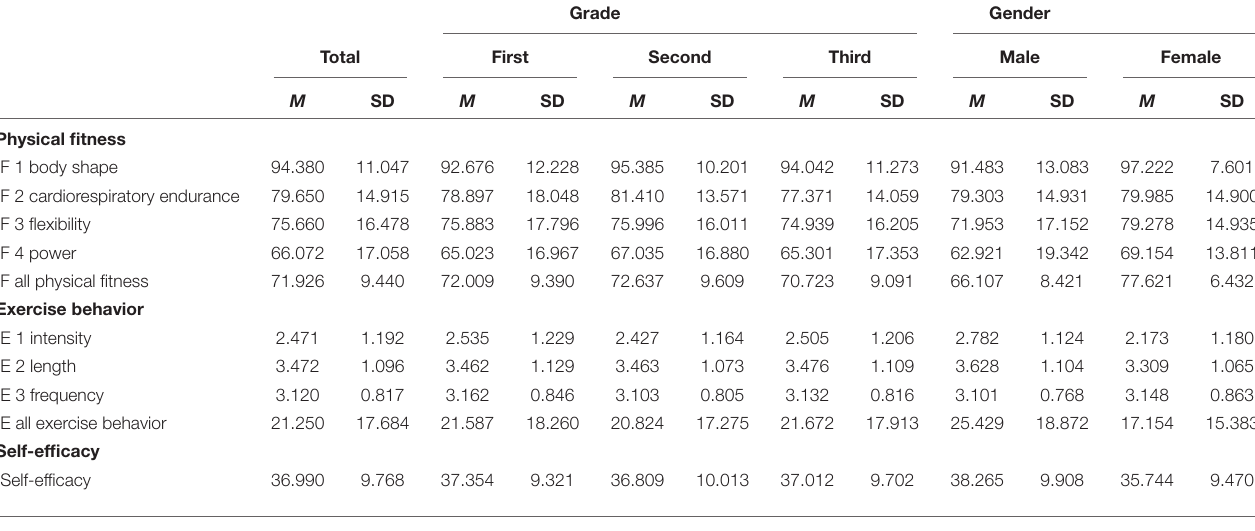
TABLE 2 | List of descriptive data ( N =